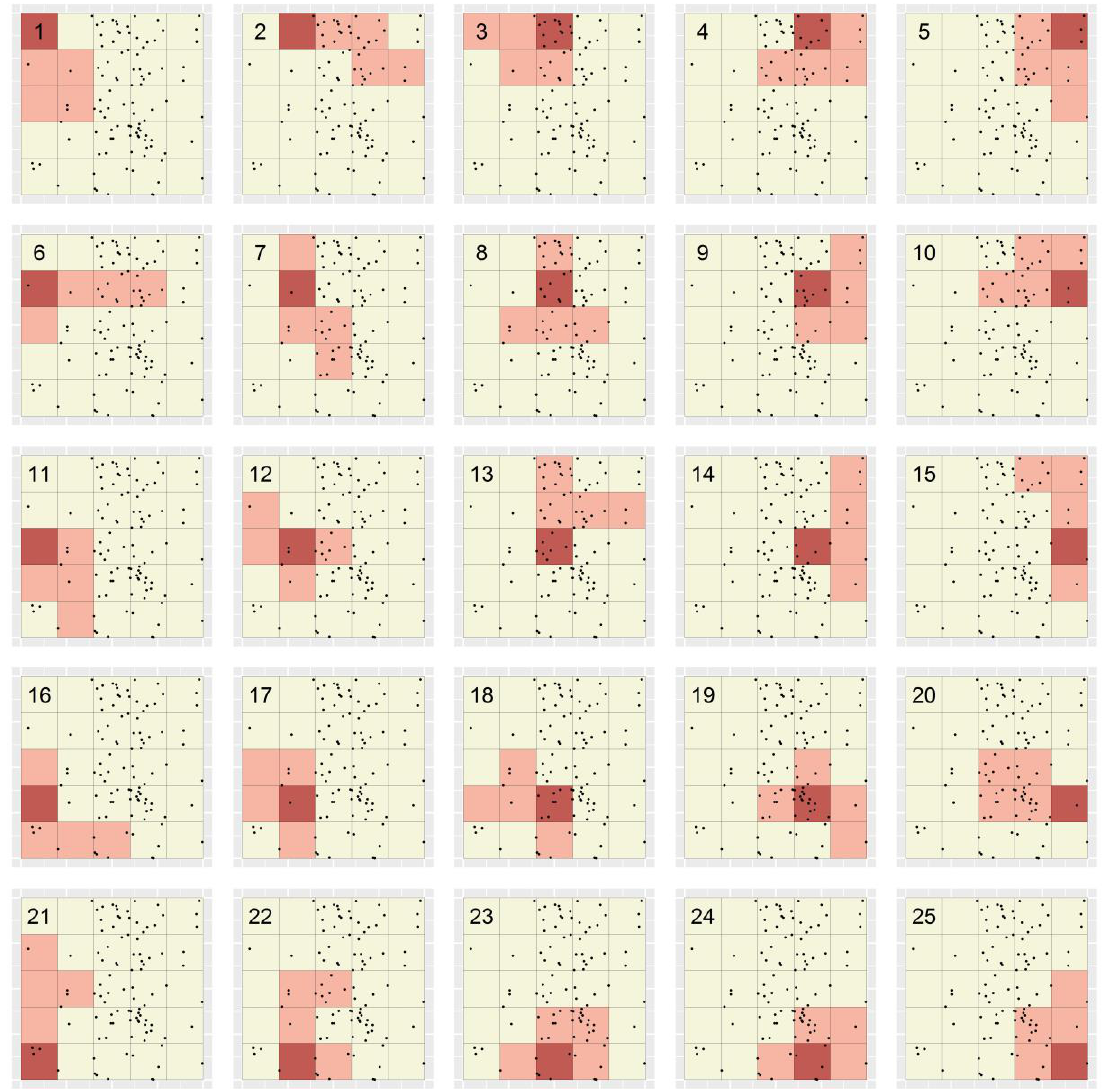
Figure 2. Polygons created within the STA applied to a simulated point location dataset of 100 disease cases. Black dots depict the locations of simulated cases, and grid lines represent the set of minimal units specified for the STA. In each panel, the pink shaded region represents the single polygon created beginning with seed unit (shaded